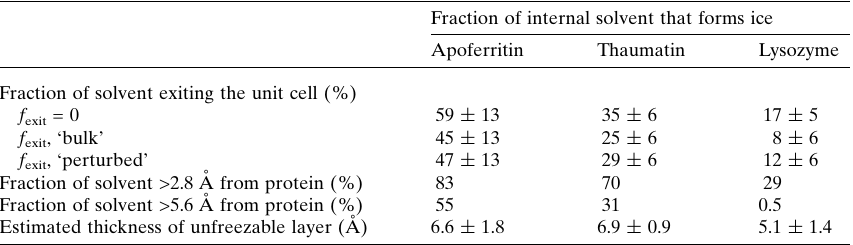
Fraction of internal solvent that forms ice